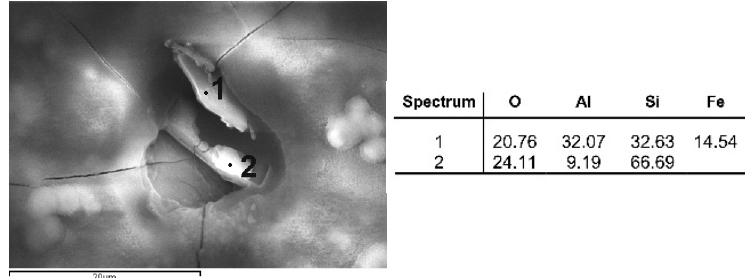
Figure 14. Cathodic effect of silicon and intermetallic particles [116].